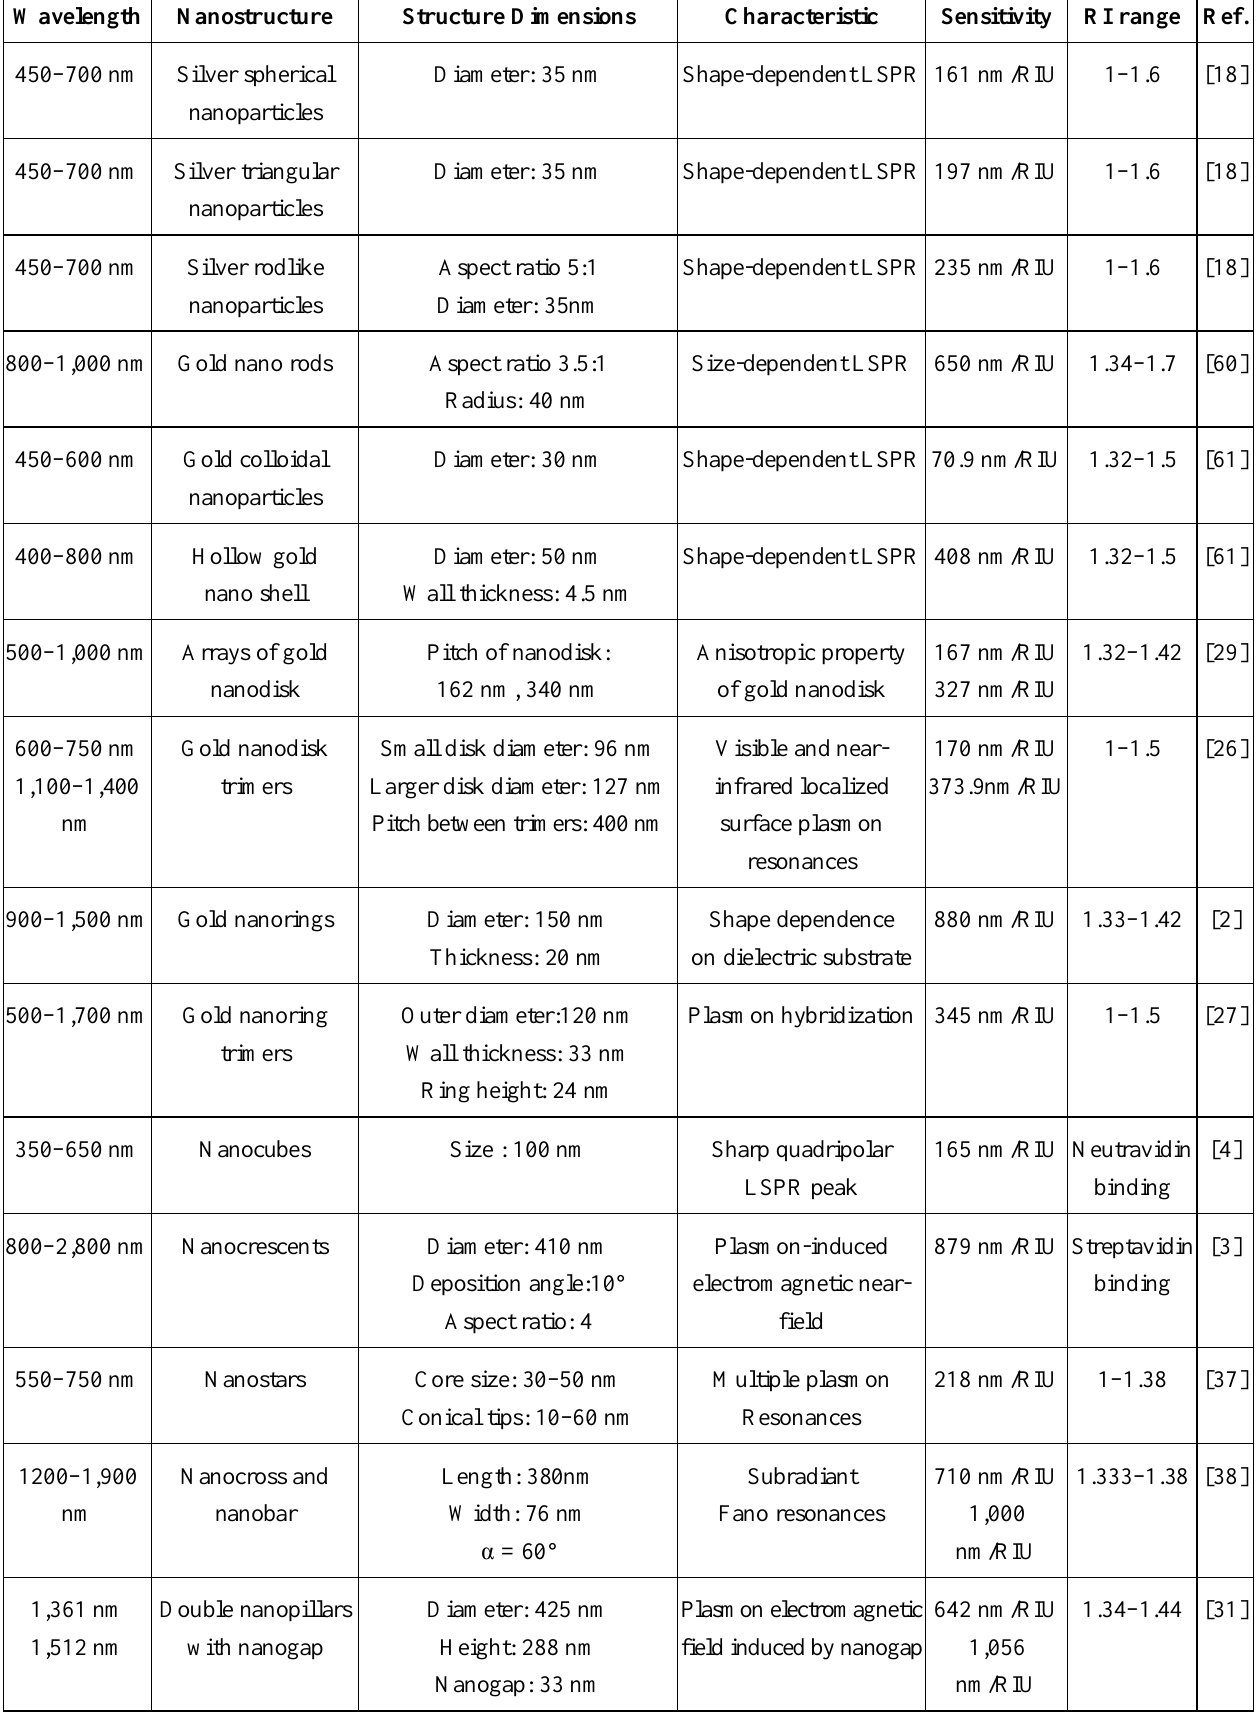
Table 1. Sensing characteristics of plasmonic nanostructures. ( RI : Refractive